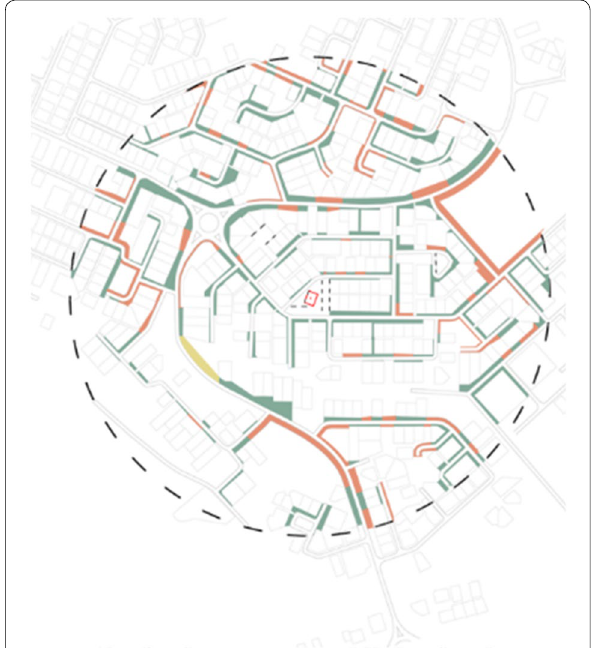
Fig. 3 The following map corresponds to the questions on pedestrian infrastructure in the neighborhood of Al Ansab